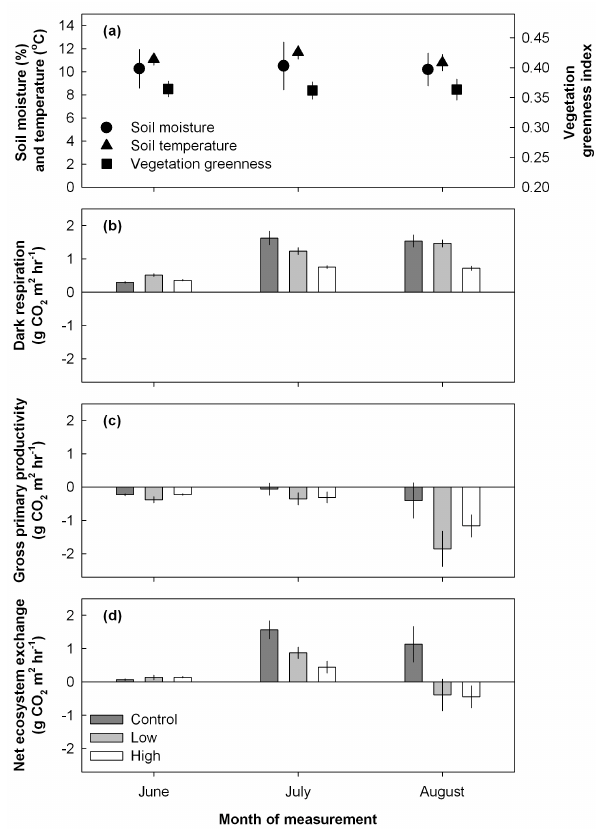
Fig. 2. Changes in soil and vegetation properties (a) , forest floor fluxes of CO 2 from R (b) , GPP (c) and NEE (d) in plots with dif- ferent N addition rates over the growing season. Values of GPP and NEE are standardized to a light intensity of 600µmolm − 2 s − 1 . Pos- itive values denote net release of CO 2 from the forest floor into the atmosphere, error bars represent SE ( n =